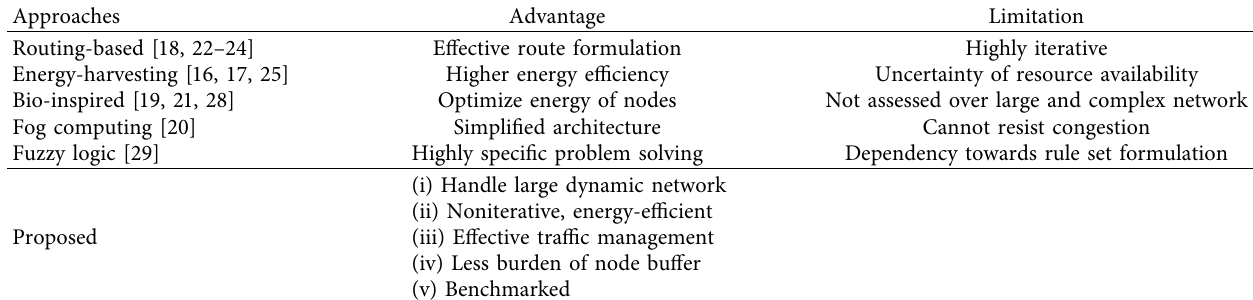
Table 1: Comparison with energy-efcient scheme.